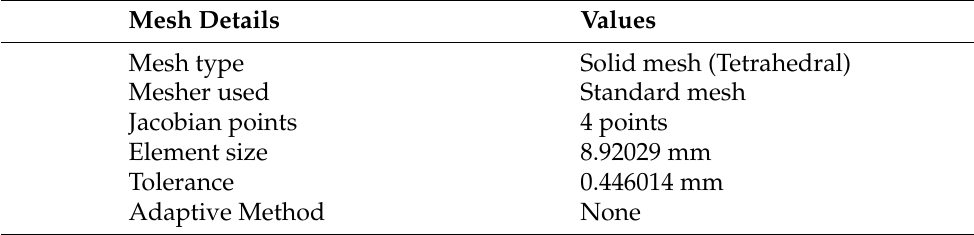
Figure 16. Deflection in members of chain 1 due to external loading. Table 2. Details of finite element analysis.